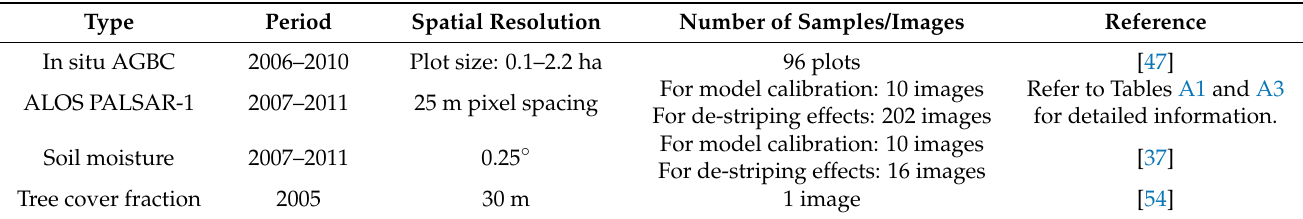
Figure 3. Change in soil moisture for three example plots with low (12 tC/ha, red line), medium (23 tC/ha, green line), and high (50 tC/ha, blue line) AGBC. Monthly precipitation estimates (dotted line) were plotted from Tropical Rainfall Measuring Mission (TRMM) data version 3B43 v7 from Google Earth Engine [53]. Note that monthly precipitation estimates are given in mm/h. Table 1. Data used in this study for model calibration and validation.